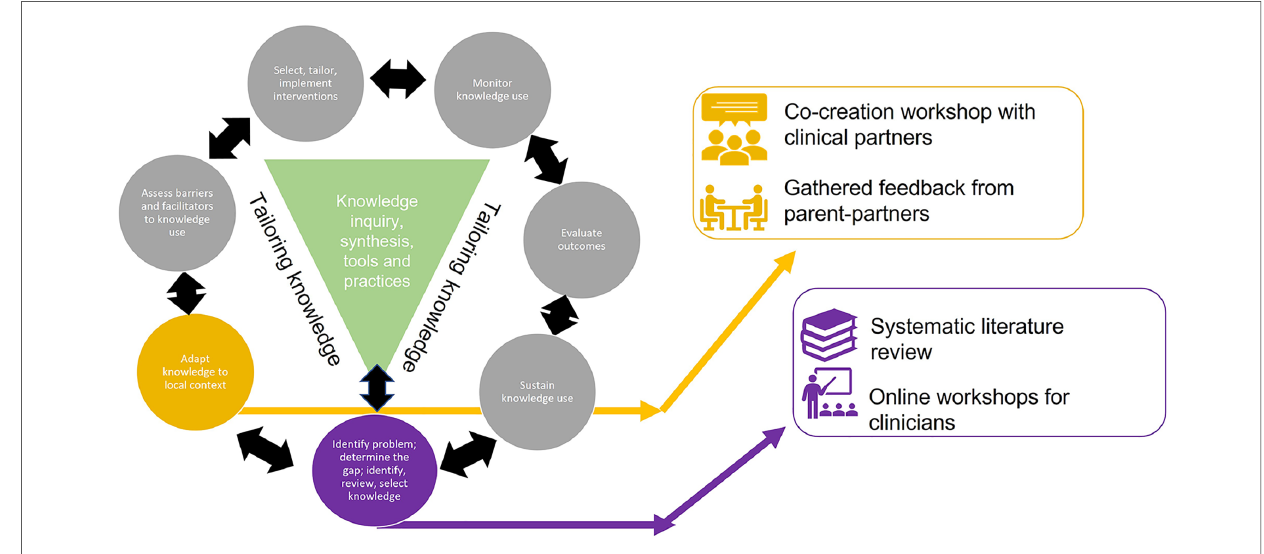
FIGURE 1 Knowledge to Action framework in the design of